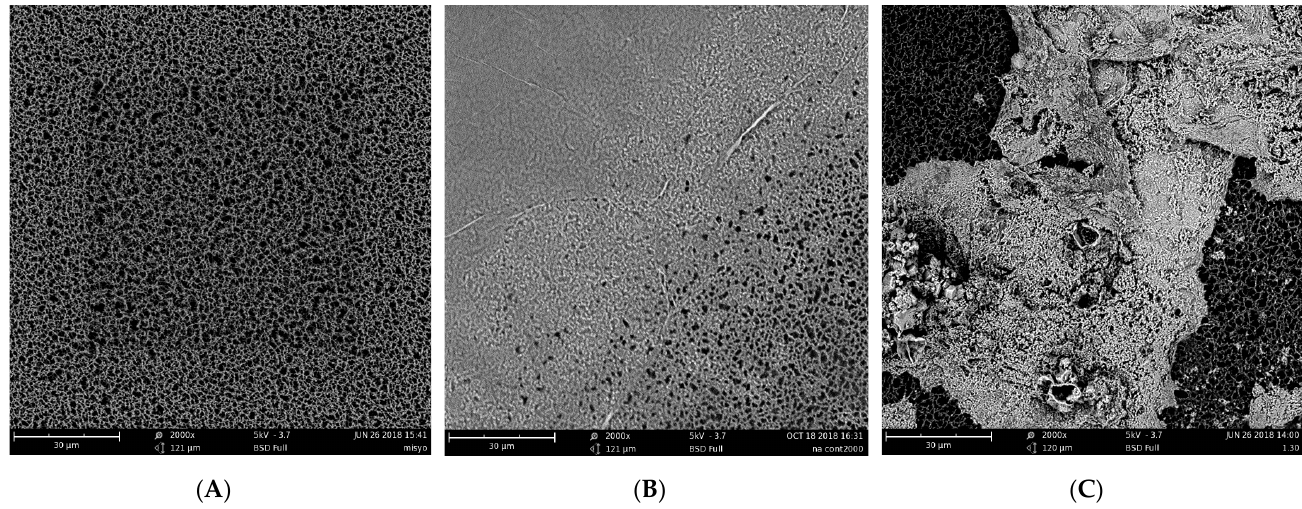
Figure 1. Scanning electron micrographs of C. jejuni biofilms on filter paper subjected to HSSP treatment (×2000, bars: 30 µm). ( A ) intact filter paper, ( B ) C. jejuni biofilms formed on the filter paper, ( C ) filter paper after HSSP treatment at 10 mg/mL for 2 min.